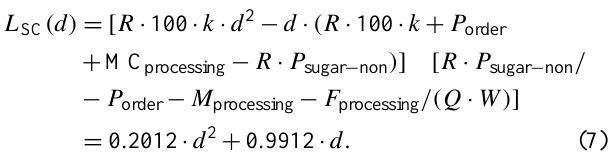
cessing cost and Q refers to the disaster-free sugarcane